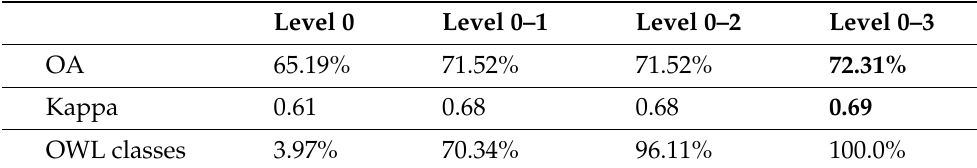
Table 6. The overall performance of the CGSCM using different LoAs. Level 0 includes LoA 0.